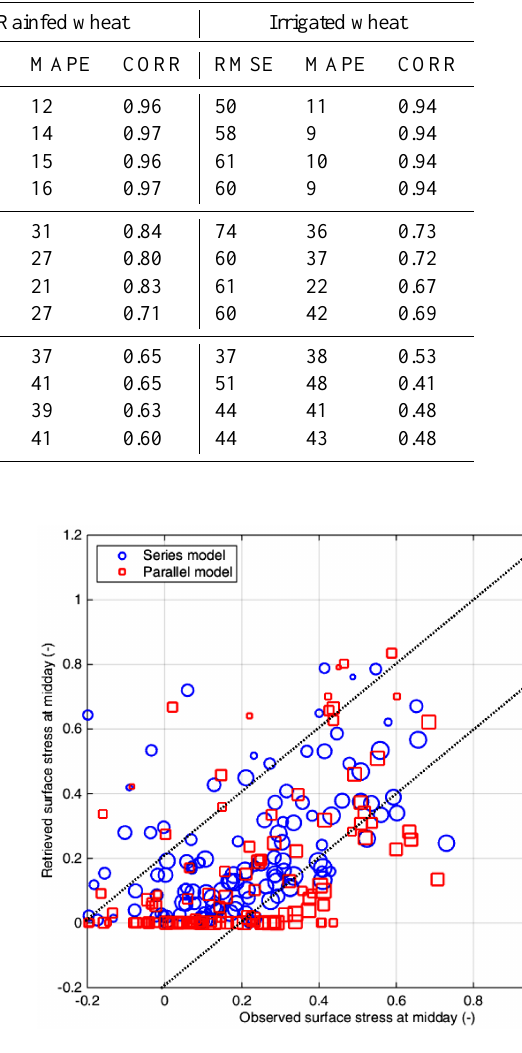
Figure 9. Same as Fig. 8, for the irrigated wheat site. surface water stress values have been estimated from po- tential evapotranspiration rates generated with the SPARSE model in prescribed conditions ( β s = β v = 1). Simulated and observed water stress values are computed as 1 − LE / LE p and 1 − LE obs / LE p , respectively, where LE obs is the instan- taneous observed latent heat flux, while LE and LE p are the simulated latent heat fluxes in actual and potential condi- tions, respectively. Total stress is thus functionally equiva- lent to 1- β . Results are shown in Figs. 8 and 9. As expected, surface stress is much higher for the rainfed than for the irri- gated wheat field. The scatter is quite large, therefore show- ing the intrinsic limit of stress retrieval from naturally noisy TIR data, as already pointed out by numerous studies